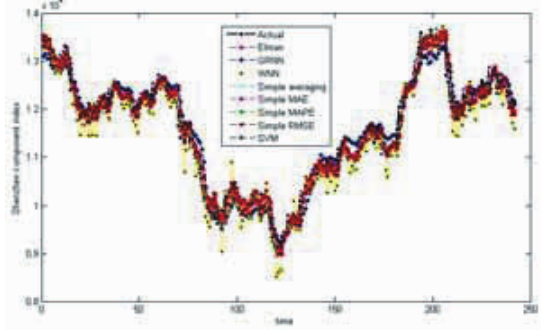
Fig. 3. The prediction of the daily stock index data of Shenzhen component index using three single base models, four linear ensemble methods, and the proposed non-linear ensemble model.